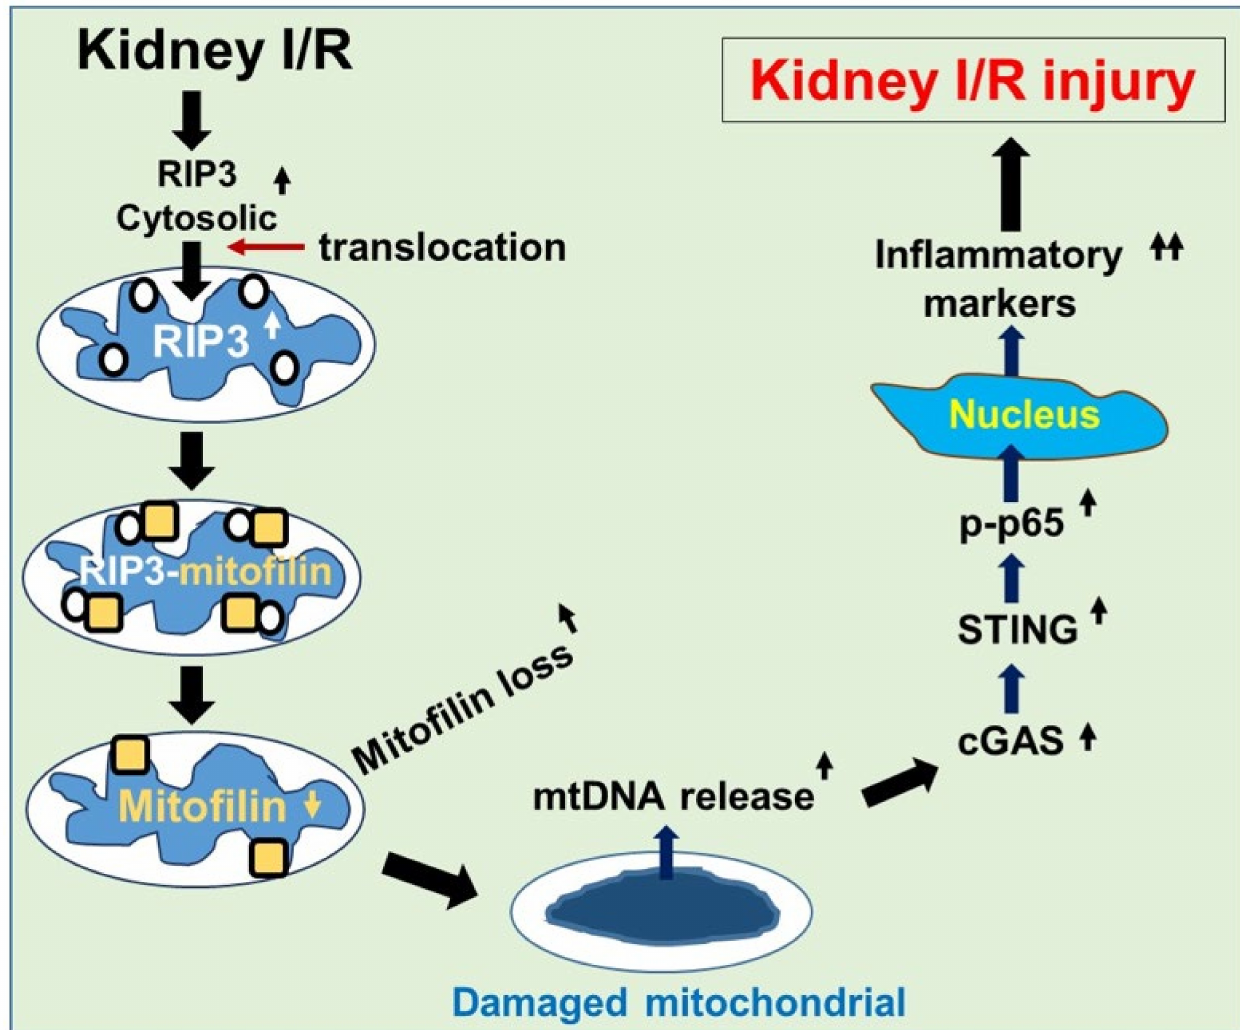
Figure 11. Graphic abstract summarizing the proposed mechanism whereby increased RIP3 in response to renal I/R reduces Mitofilin levels to amplify inflammation and exacerbates kidney injury. An increase in cytosolic RIP3 levels in response to kidney I/R promotes the translocation of RIP3 into the mitochondria, where it interacts with and favors Mitofilin degradation, leading to increased mitochondrial structural damage and dysfunction. The following increase in ROS production in the mitochondria is proposed to enable mtDNA damage and release into the cytosol, where the mtDNA activates the cGAS–STING–p-p65 pathway, leading to increased nuclear transcription of pro-inflammatory markers that subsequently exacerbate renal I/R